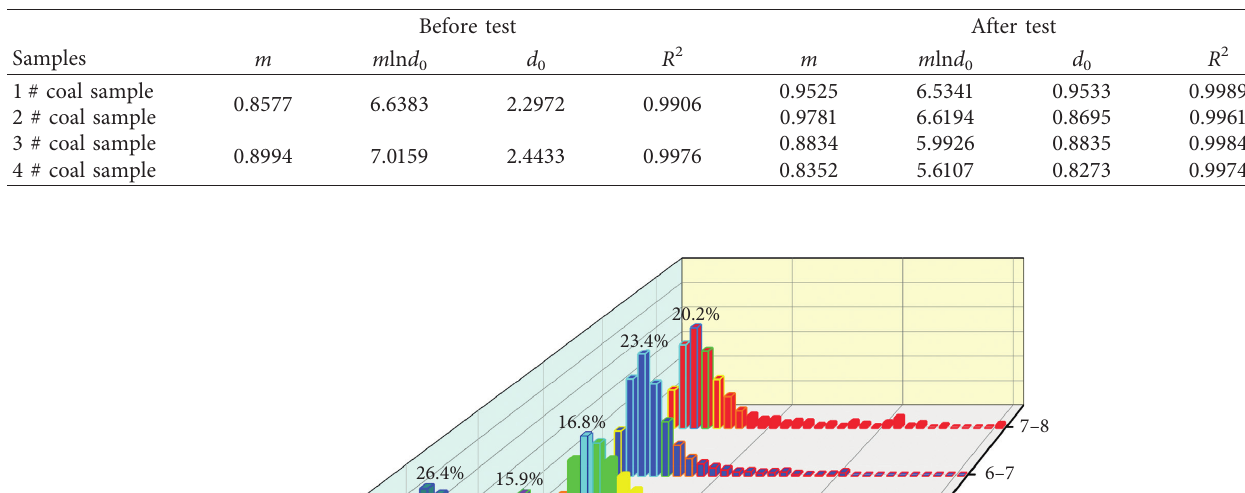
Table 3: Fitting parameters of Rosin–Rammler distribution.